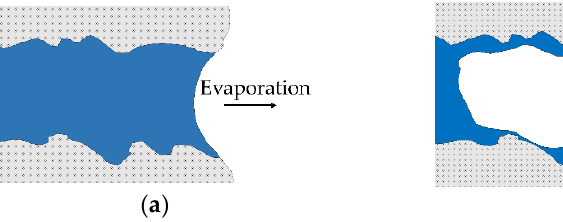
Figure 3. Scheme of the theory of drying based on [19] associated with the experimentally determined drying points. ( a ) constant rate period (Drying Point 1); ( b ) first falling rate period (Drying Point 2); ( c ) second falling rate period (Drying Point 3).